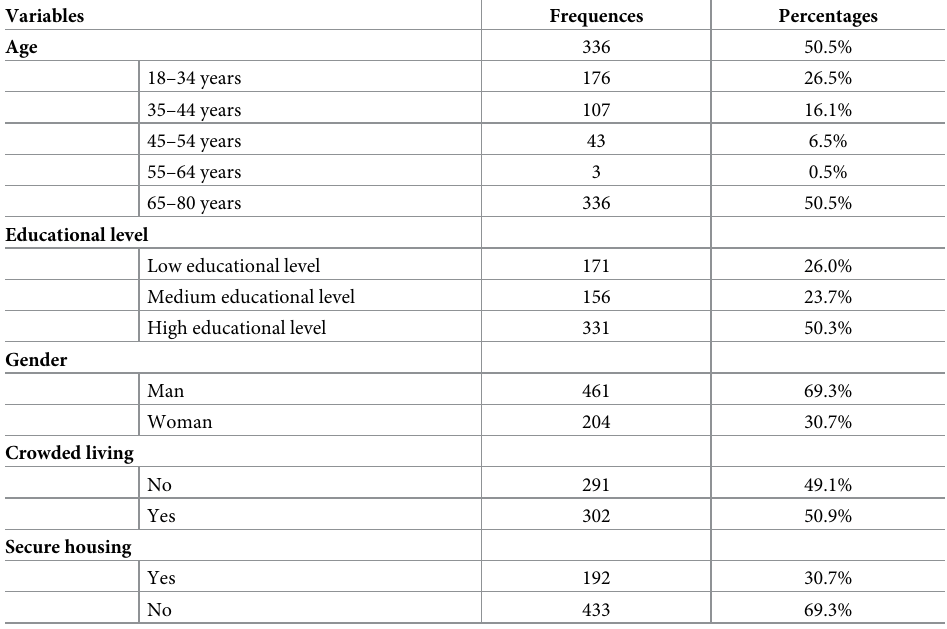
Table 1. Frequencies and percentages for the background variables.